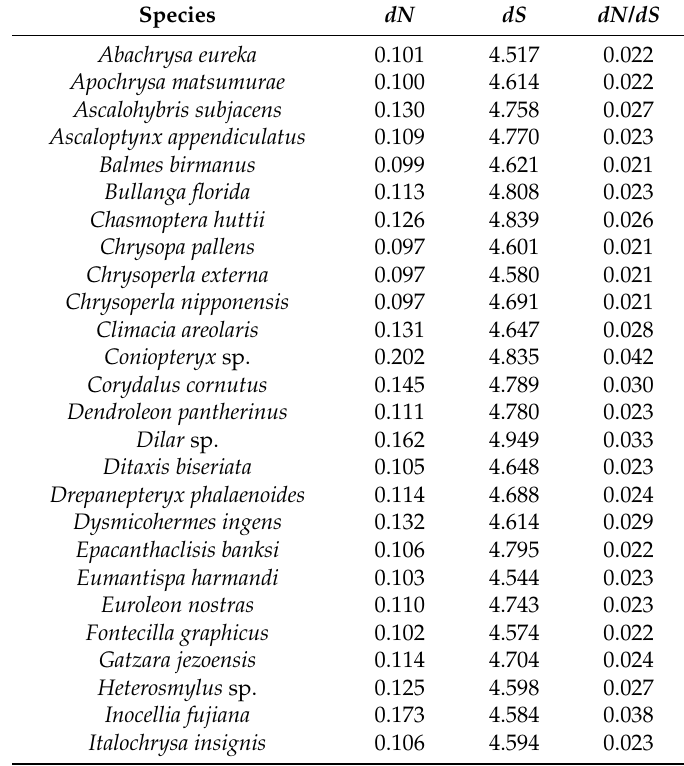
Table 4. The substitution rate analyses conducted by yn00 implemented in